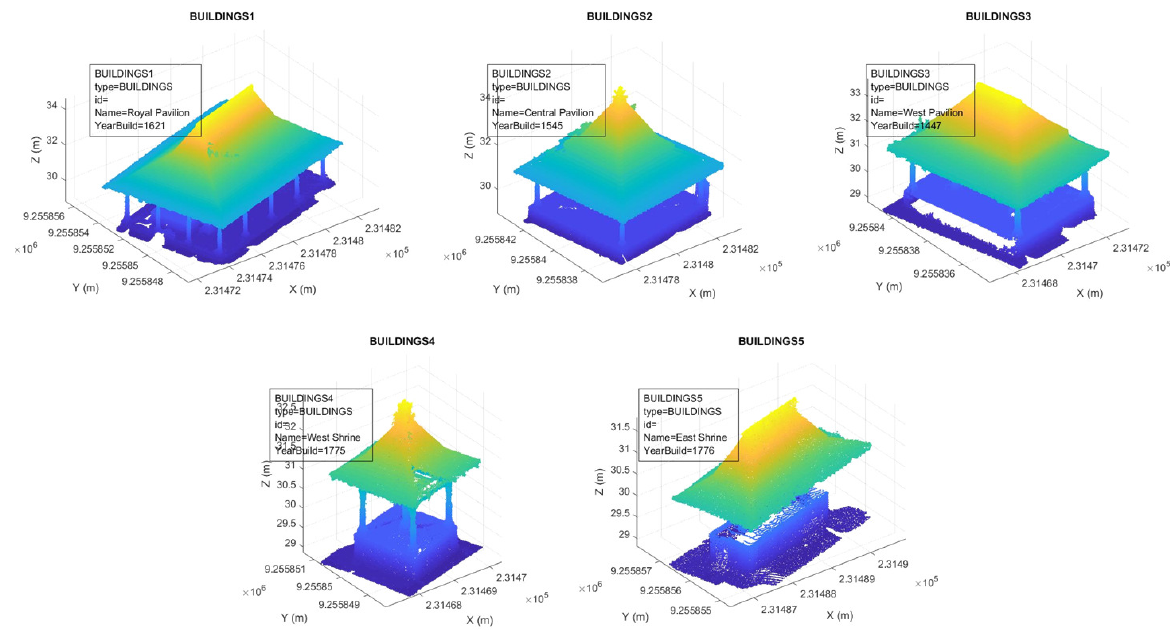
Figure 6. Result of the segmentation and semantic annotation process for each object for the class “BUILDINGS”. Number of Points Misclassified Object Manual Auto Overclassified Unclassified